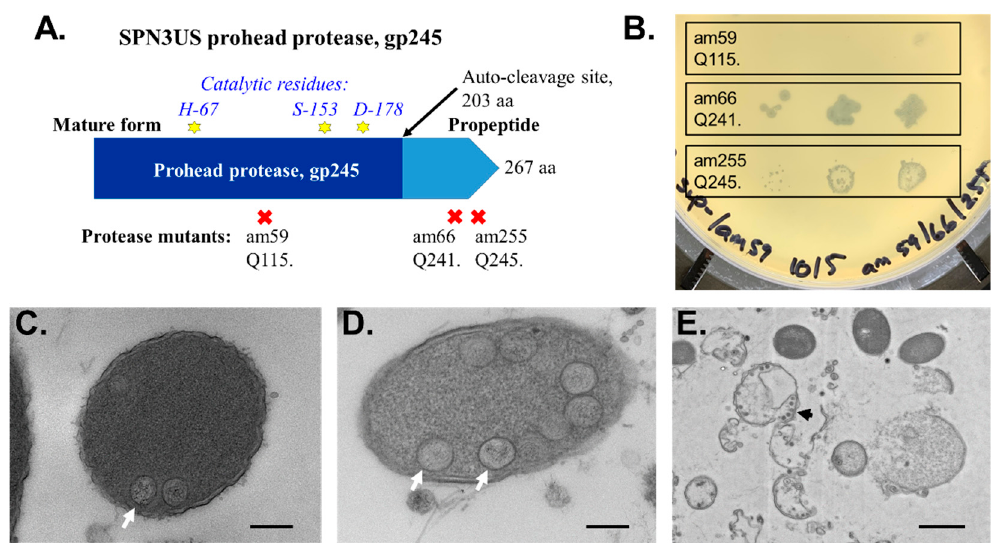
Figure 5. The first mutant of Salmonella phage SPN3US, 47 (am1)—isolated by Lindsay Black—has an amber mutation in a low copy number head ejection protein gp47. ( A ) Transmission electron micrograph of 47 (am1) grown under non-permissive conditions shows particles with an apparent wild-type phenotype, but are non-viable (reversion rate < 1 × 10 − 5 ). Space bar represents 100 nm. ( B ) The gp47 gene is located in cluster of head genes conserved in related giant phages, including Erwinia phage PhiEaH2, Cronobacter phage CR5 and Pseudomonas phages φ KZ, 201 φ 2-1 and φ PA3. Red arrowhead indicates a gene product undergoes cleavage by the prohead protease. Images adapted from Ali et al. [54].